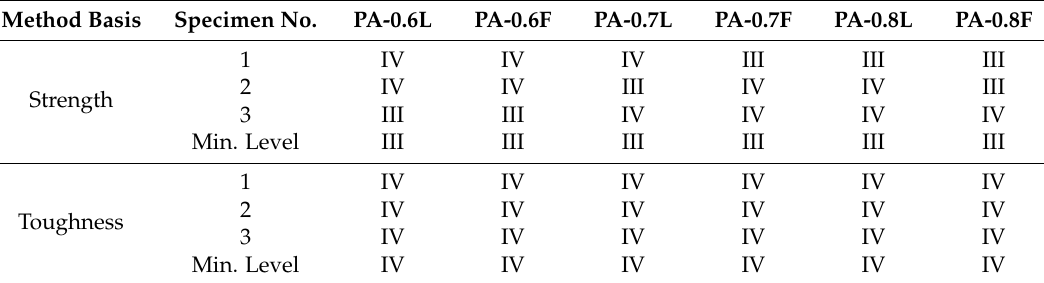
Table 8. Morgan level based on strength and toughness.